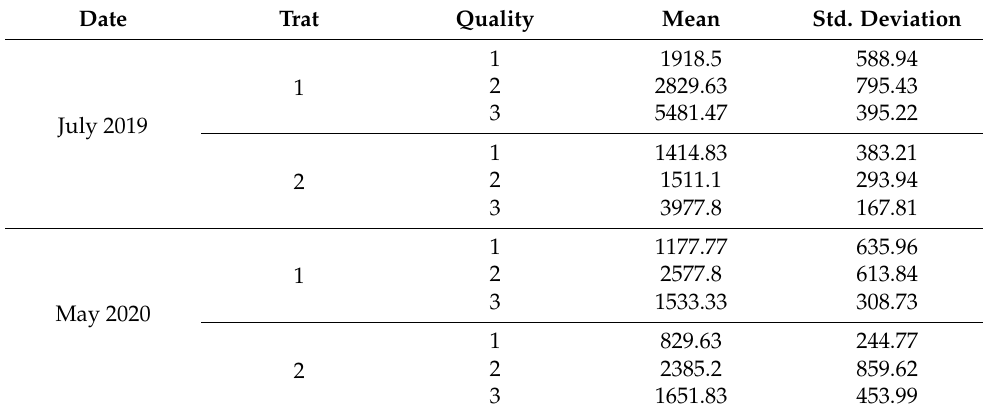
Table 3. Cob production data (expressed as kg of cob/ha) for 2019 and 2020 harvest, T1 and T2 treatments and three qualities: 1: high, 2: medium and 3: low (without, poor/moderate and high pest attack,